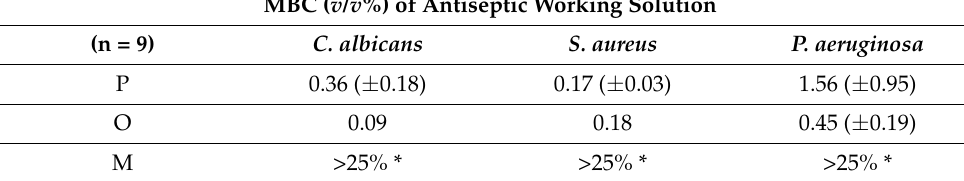
Table 1. Minimal Biocidal Concentration [MBC] of P, O, M antiseptics against the test strains (n = 9) of C. albicans , S. aureus , P. aeruginosa . MBC ( v/v %) of Antiseptic Working Solution (n = 9) C.